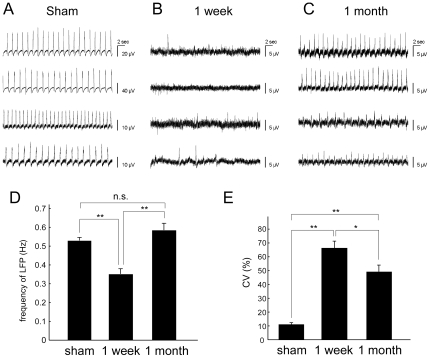
Spontaneous LFP oscillation is restored within a 1 month recovery period.(A) Periodic LFP oscillation in the sham-operated PC. (B) Infrequent and irregular burstings in the 1 week recovery PC group. (C) Periodic LFP oscillation in the 1 month recovery PC group. In (A)–(C), all the recordings were made from different slugs. (D) Quantitative data on oscillatory frequency (mean ± SE) show that the frequency was significantly lower 1 week following PC lesion as compared to sham-operated slugs, while 1 month following PC lesion LFP frequency was comparable to that of the sham-operated group. (E) Quantitative data on the coefficient of variation (CV) of bursting intervals (mean±SE) in the PC show that the bursting interval 1 week following a lesion was significantly more variable than the sham-operated PC group. While there was some recovery to stable oscillation in the 1 month recovery group, it did not return to a level comparable to that of the sham-operated group. sham, n = 64; 1 week, n = 30; 1 month, n = 64. *P<0.05, **P<0.001 by Student's t-test (two-tailed).